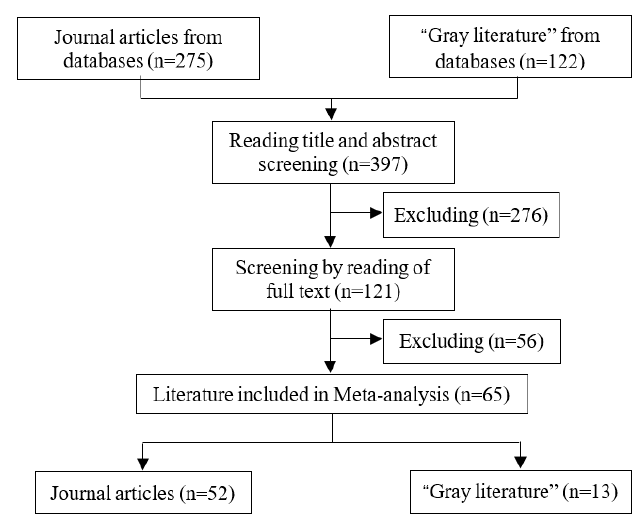
Figure 1. Literature screening processes and results.